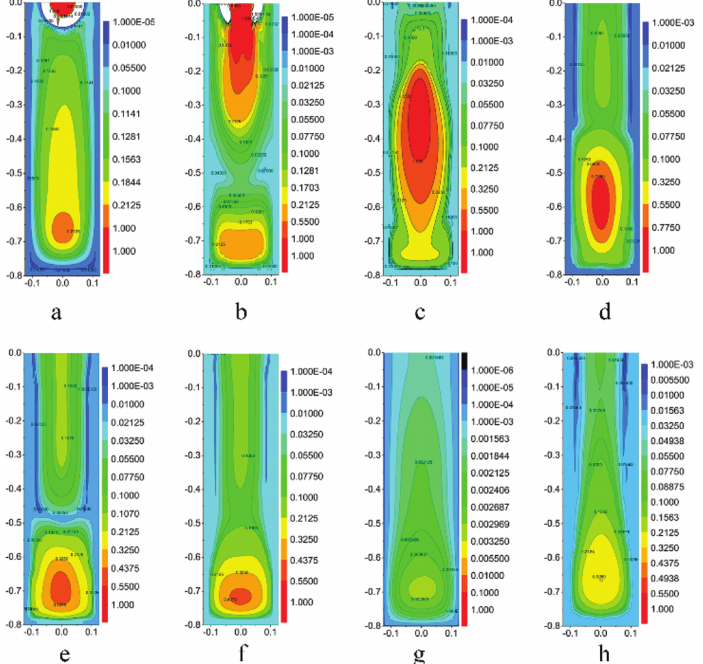
Figure 4: Steel velocity distributions at different slab cross sections: 0.1m (a) 0.2m (b) 0.3m (c) 0.4m (d) 0.5m (e) 0.6m (f) 0.7m (g) 0.8m (h) from the meniscus.